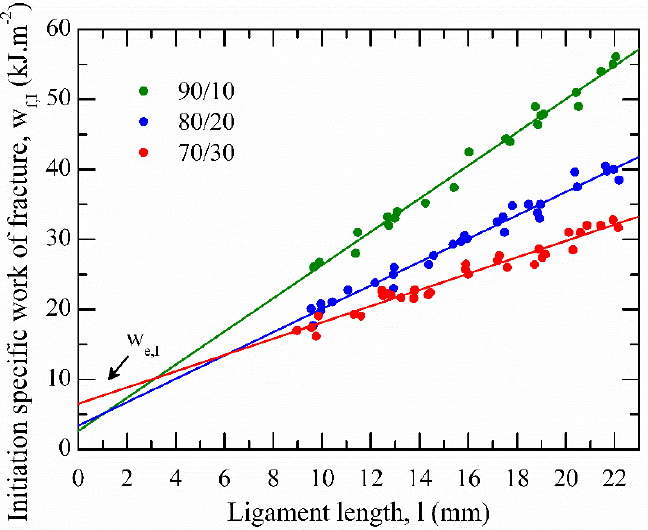
Figure 12. Plot of initiation-related specific work of fracture versus ligament length for the studied polymeric blends. All points are experimental and the fracture parameters were determined by the best linear fit according to Equation (4). Table 5. Specific essential EWF parameter related to initiation along with the percentage ratio of initiation/global essential parameters of rPP/rPET-O calendered sheets.